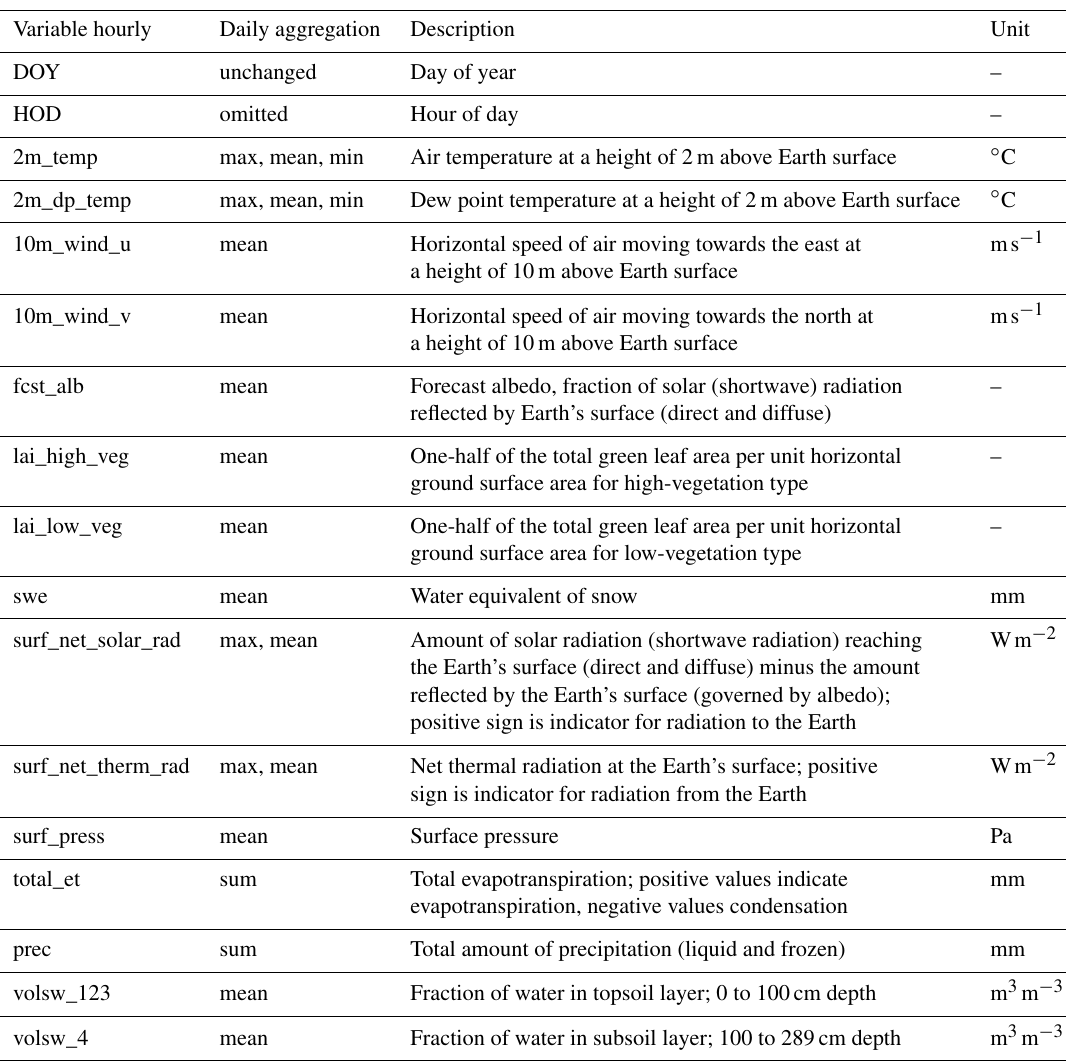
Table A2. Meteorological variables from ERA5-Land dataset (Muñoz Sabater,